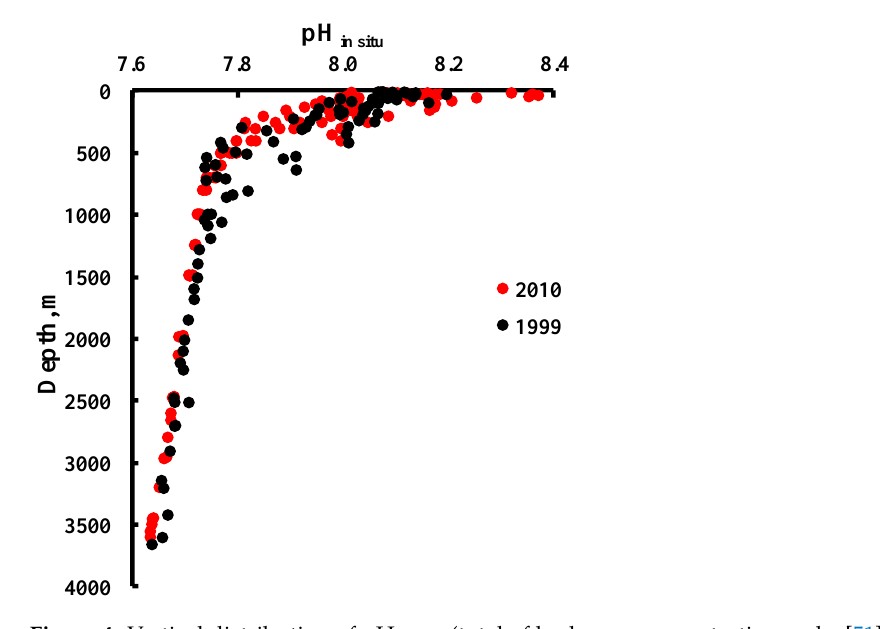
Figure 4. Vertical distribution of pH in situ (total of hydrogen concentration scale, [51]) in seawater of the JES. Red points represent data obtained in 2010 (R/V Hakuho Maru KH-10-2); black points represent data obtained in 1999 (R/V Revelle, Khromov).